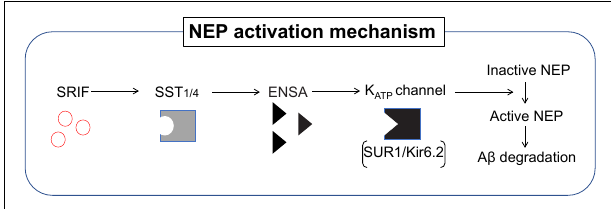
FIGURE 9 | Role of ENSA in the regulation of NEP activity. Schematic illustration of the mechanism describing NEP activity in the brain. ENSA, a downstream protein of SST-SST 1 / 4 signaling, plays a role as a ligand of the K ATP channel composed of sulfonylurea receptor subunit 1 (SUR1) and inwardly rectifying K + channel 6.2 (Kir6.2), resulting in the activation of NEP. SST 1 / 4 can be either a combination of SST 1 and SST 4 homodimers or an SST 1 /SST 4 heterodimer. FIGURE 10 | Propagation of AD-tau in mouse brains. Propagation of tau in